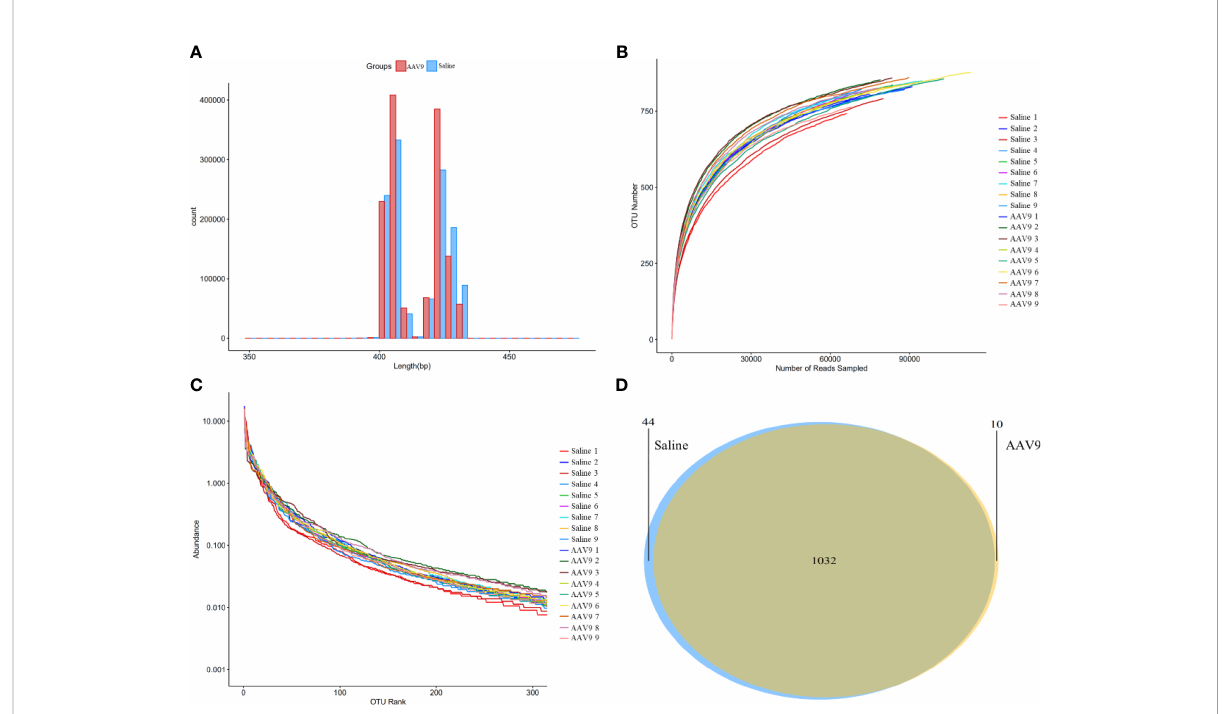
FIGURE 2 Sequencing data analysis and OTU cluster analysis. (A) The length distribution diagram of the valid data. (B) The rarefaction curve for each sample. (C) The rank-abundance curve for each sample. There was no signi fi cant difference between the AAV9 group and the saline group. (D) Venn diagram of the two groups. Different groups are represented by different colours, and the numbers in the overlapping parts indicate the number of species in common in the two